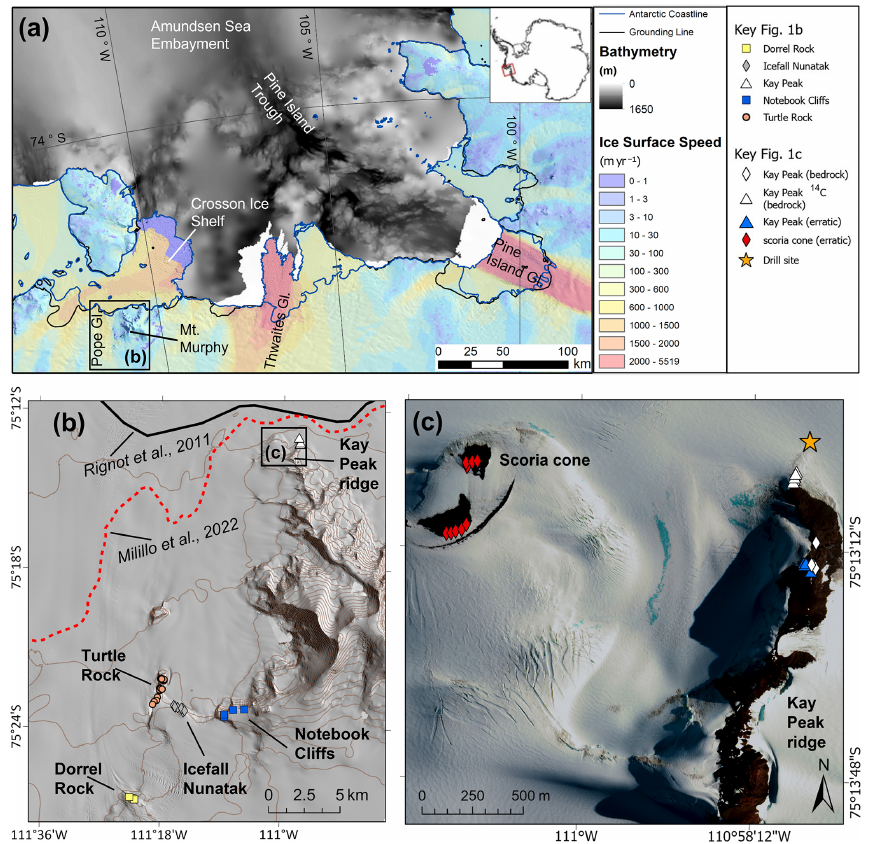
Figure 1. Location of the study area in the context of Mt. Murphy and the wider ASE. (a) ASE area map displaying regional ice streams, ice velocities (Mouginot et al., 2012) overlayed on Reference Elevation Model of Antarctica (REMA) (Howat et al., 2019) regional bathymetry (Arndt et al., 2013), 2011 grounding line (black line; Rignot et al., 2011) and Antarctic coastline (blue; Antarctic Digital Database, version 7.2). (b) Mt. Murphy site map generated using REMA-derived hillshade, with contours representing 100m intervals. Locations of previous exposure ages (Johnson et al., 2020, 2008) indicated by coloured symbols shown in Fig. 1b key; also displayed are both the 2011 grounding line (same as in Fig. 1a) and the most recent localised grounding line (dotted red; Milillo et al., 2022). (c) High-resolution satellite imagery (732 false colour composite), DigitalGlobe products, © WorldView 2 2013 DigitalGlobe, Inc., a Maxar company, showing scoria cone and Kay Peak ridge. Drill site indicates location of subglacial bedrock core recovery by the GHC subglacial drilling project (Boeckmann et al.,